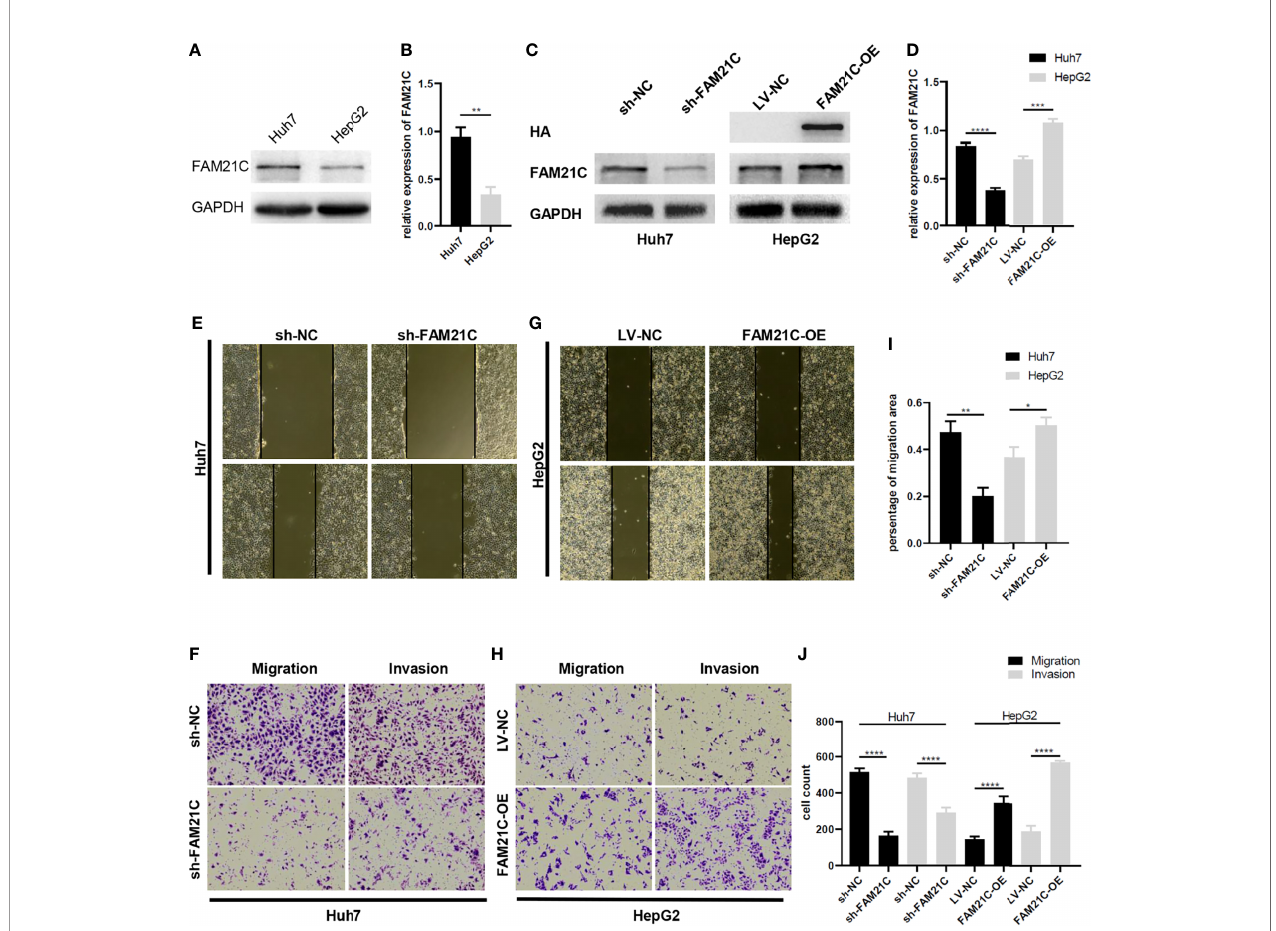
FIGURE 3 | FAM21C increases HCC cell invasion and migration in vitro . (A) The wild-type FAM21C content of Huh7 and HepG2 cells was detected by western blot. (B) Histograms show the relative expression levels of FAM21C. (C) Western blotting was used to detect the protein levels of FAM21C in Huh7 and HepG2 after infected with sh-FAM21C and FAM21C-OE lentivirus compared with the respective negative control. HA indicated that the overexpression of HA-FAM21C fusion protein was effective. (D) Histograms show the relative expression levels of proteins. (E – H) Wound healing, Transwell and invasion assay were used to detect the migration and invasion potential of Huh7 and HepG2 cells after transfected with knockdown or overexpression lentivirus respectively. The invasion and migration ability of Huh7 was decreased after FAM21C knockdown; the invasion and migration ability of HepG2 was increased after FAM21C overexpression. Scale bar: 200×. (I, J) Histograms show the percentage of migration area and cell count after the FAM21C expression was modulated. Data are represented as the mean ± SD, n=3. * P < 0.05, ** P < 0.01, *** P < 0.001, **** P <